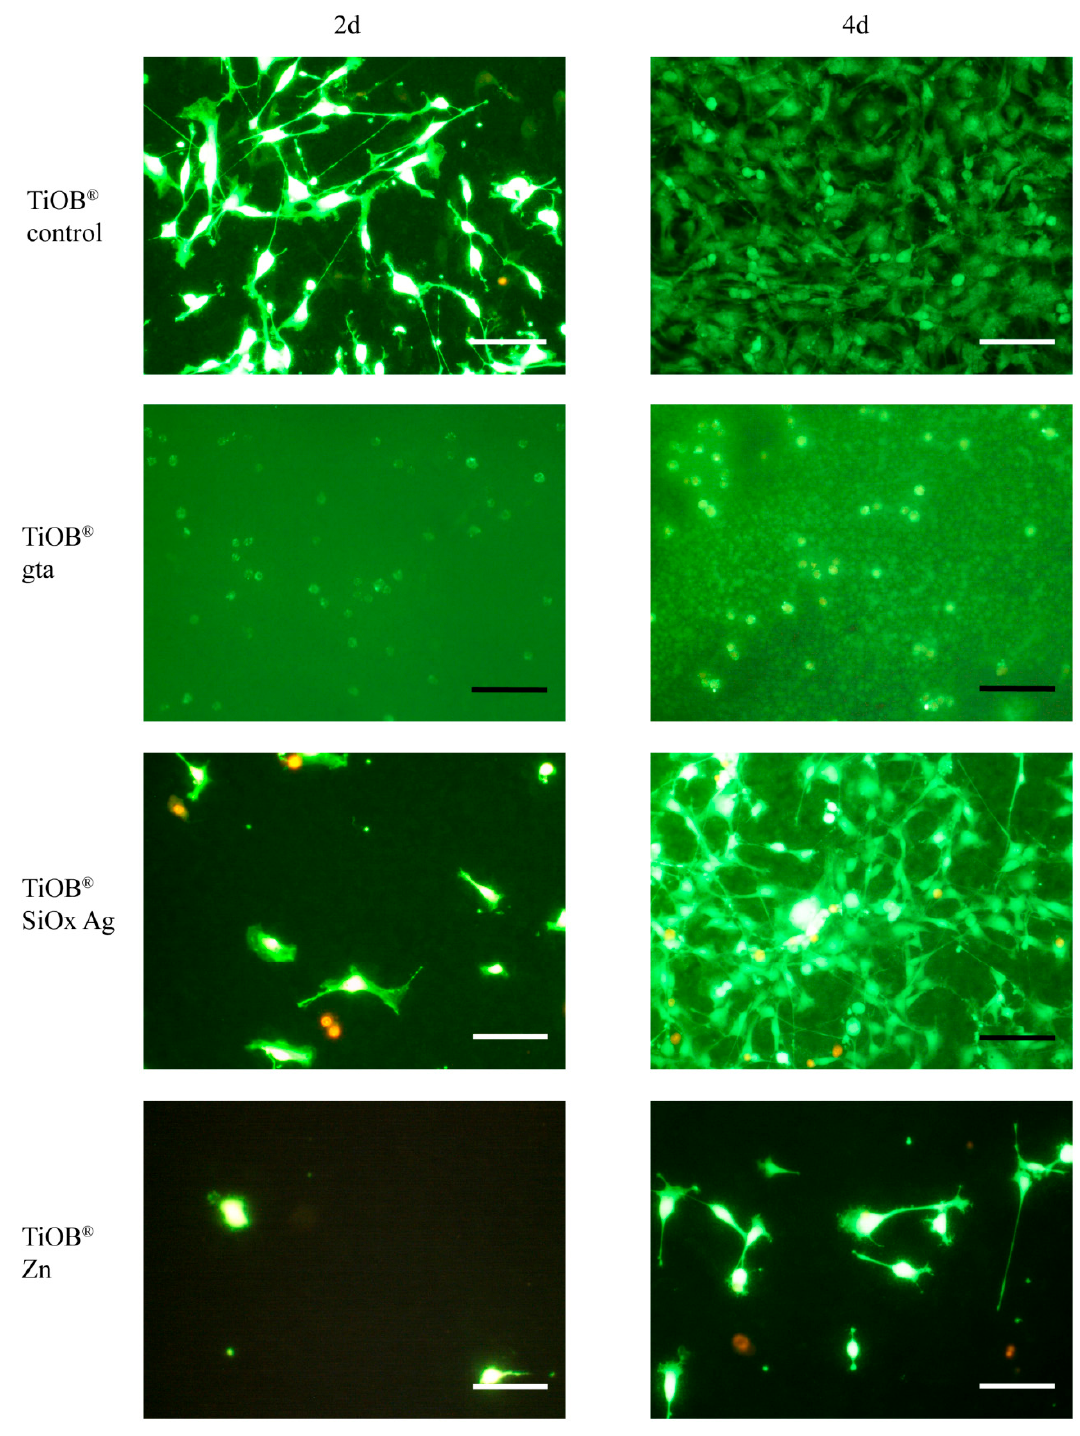
Figure 5. Laser scanning microscopy images of MC3T3-E1 cells cultivated in direct contact with non-functionalized TiOB ® (TiOB ® control), TiOB ® gta, TiOB ® SiOx Ag, and TiOB ® Zn for 2 and 4 days. Cells were stained by FDA/Ethidium bromide. Viable cells appear in green whereas nuclei of non-viable cells are shown in red.